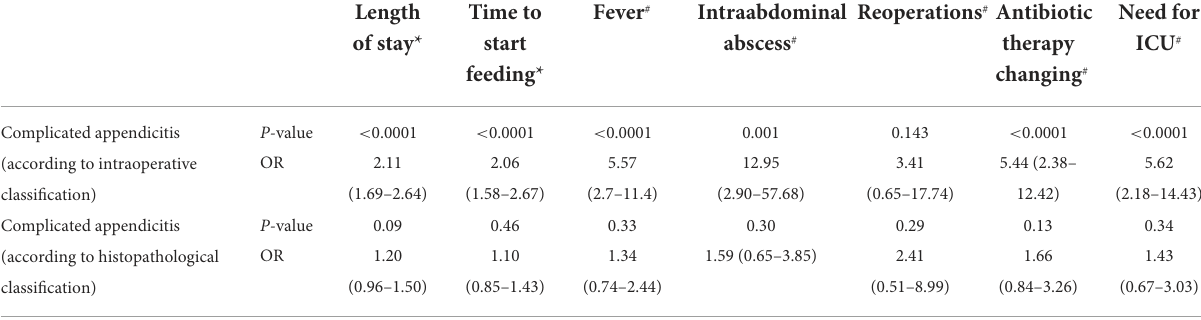
TABLE 5 Predictive analysis of complex appendicitis, according to histopathological and intraoperative classifications, for post-operative clinical